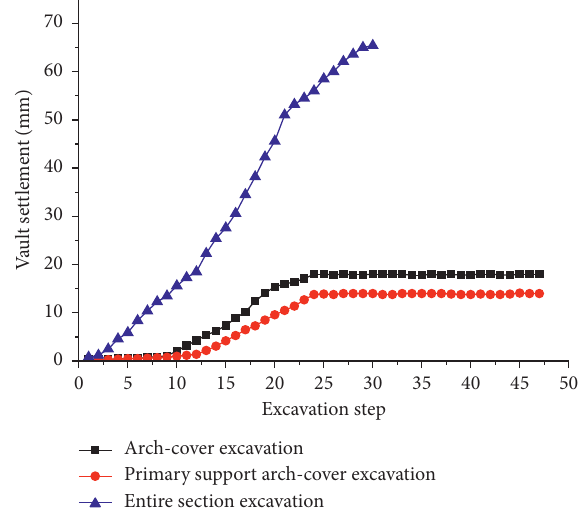
Figure 16: Vault settlement curves with sustainable excavation.